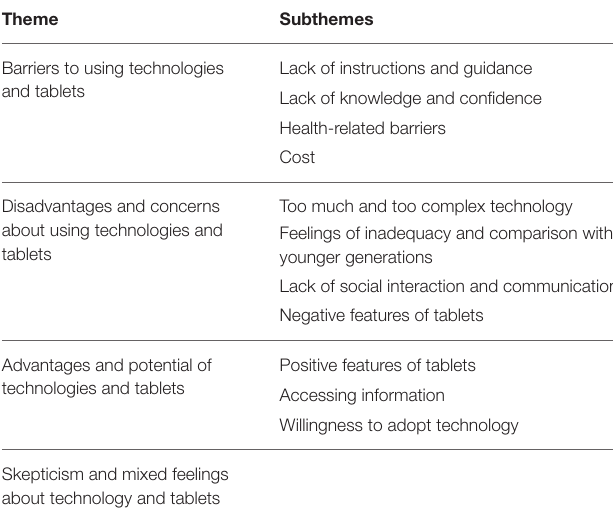
TABLE 2 | Focus group themes and